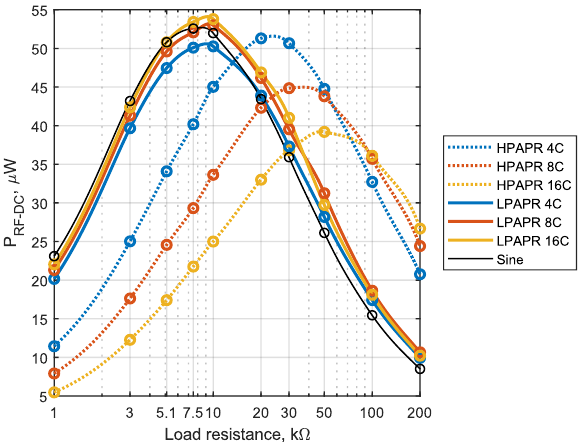
Fig. 9. RF-DC conversion output power levels for different load resistances and different signal